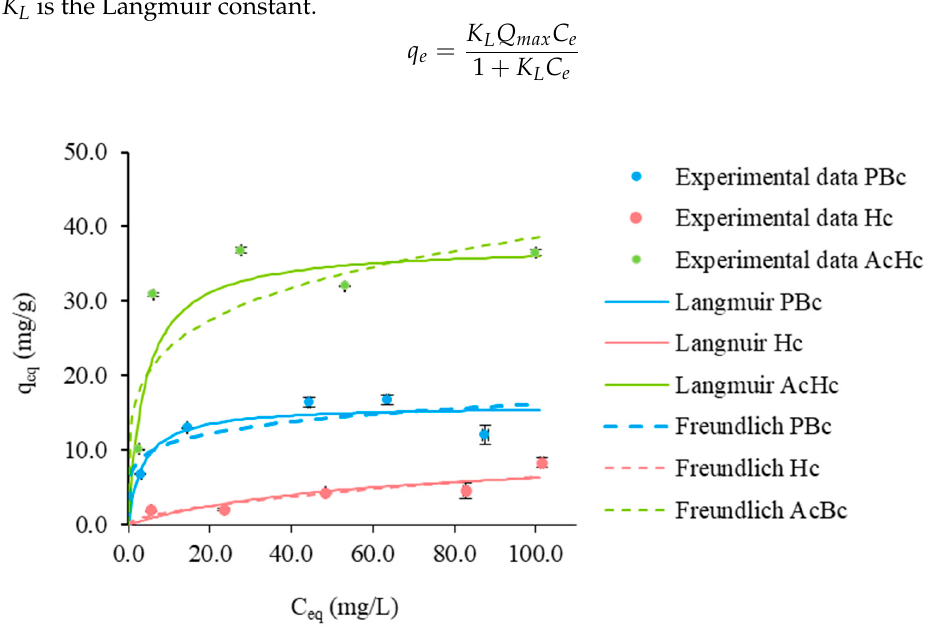
Table 4. Chemical characterization of Rosia Montana drainage water.